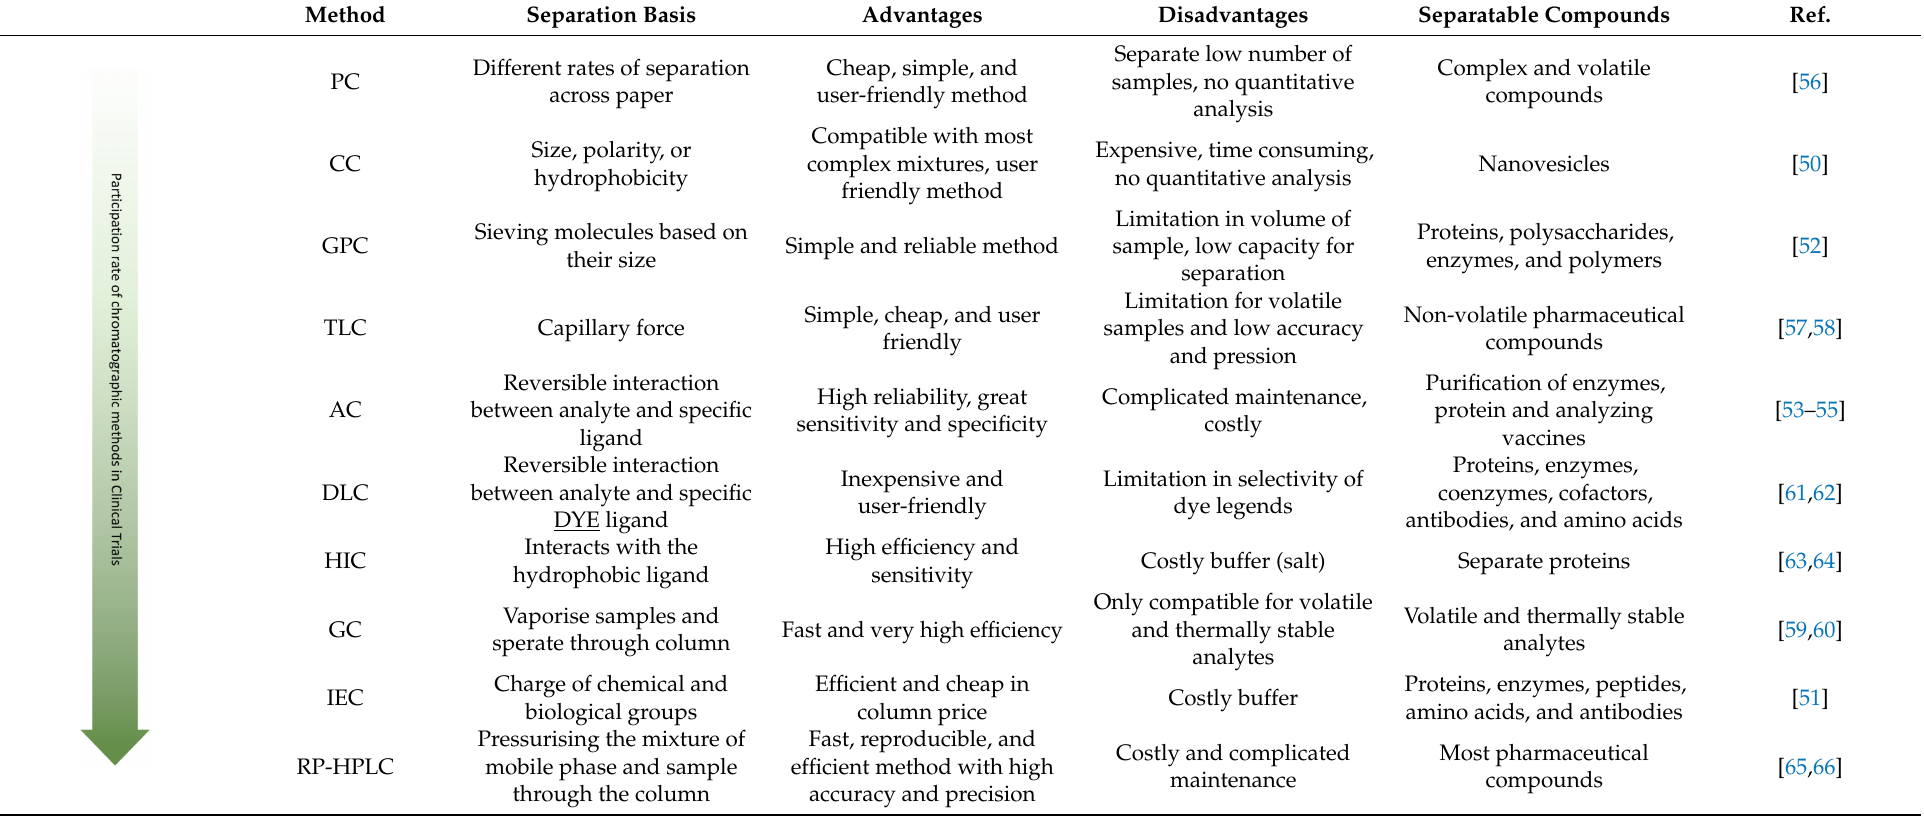
Table 1. Application, advantages, and disadvantages of chromatographic methods in clinical trials. and participation